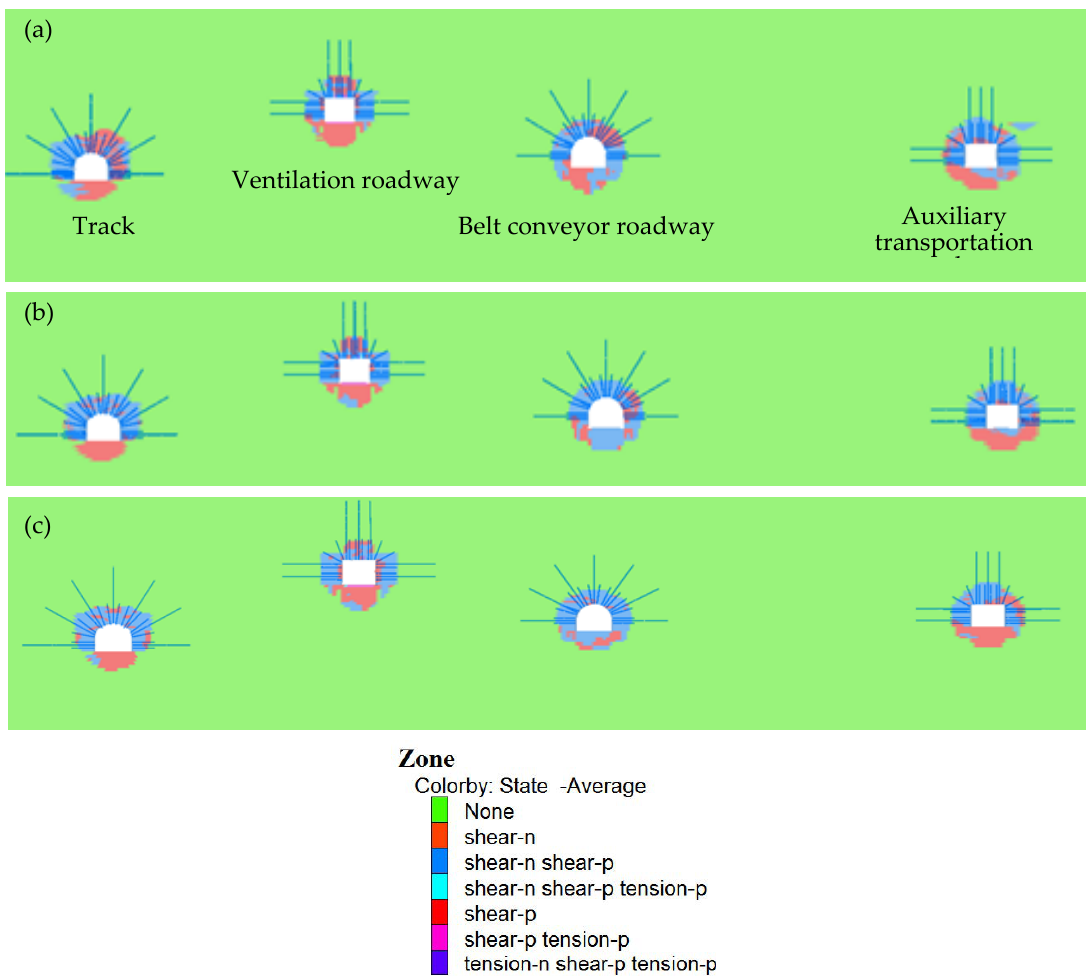
Figure 16. Distribution of plastic zone at different distances between working face and roadway: ( a ) 50 m, ( b ) 75 m, and ( c ) 100 m.